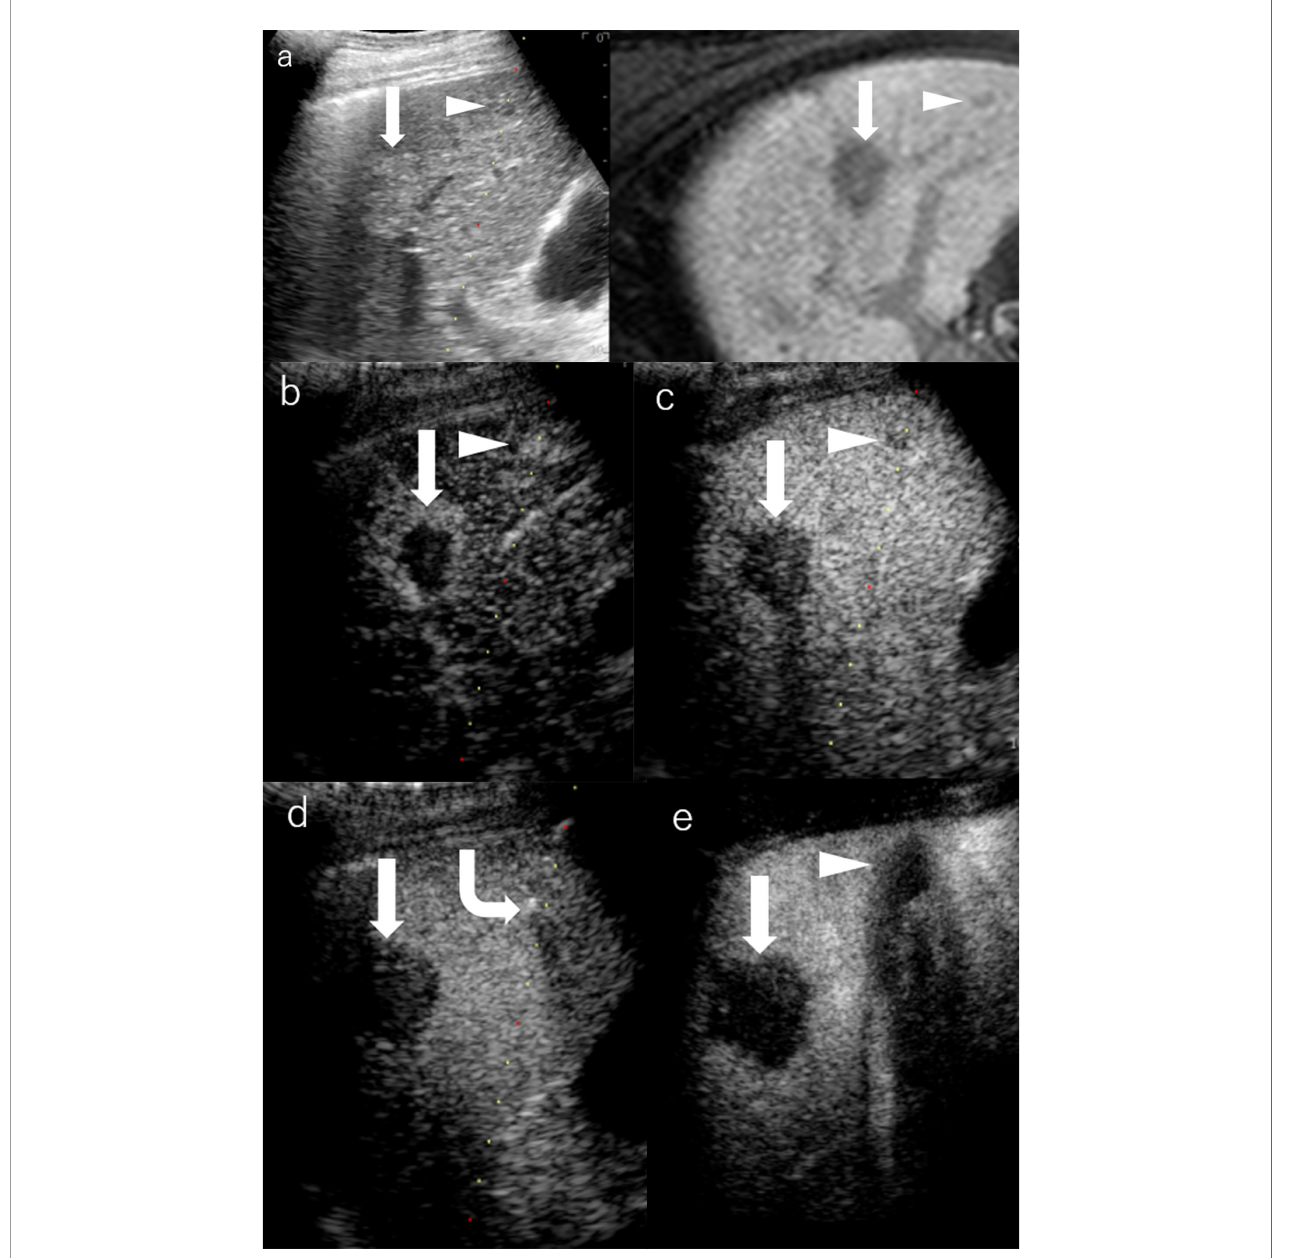
FIGURE 4 | Images of a man in his seventies with a pathological diagnosis of moderately differentiated hepatocellular carcinoma (HCC) and had a history of cirrhosis and HCC. The hepatobiliary phase of EOBMRI (right side), as the reference, was combined with conventional grayscale US (left side), displayed an 8-mm indistinctive hypointense area (the triangular arrow) in segment V on the same screen for the fusion imaging (A) . The extrasmall lesion was hypervascular in the arterial phase of Sonazoid-enhanced ultrasound (US) (B) , while the post-vascular phase indicated it to be a slightly hypoechoic area (C) . Pathway guidance was ready for radiofrequency ablation (RFA) needle manipulation on real-time US (B – D) , along with tracking for the metallic needle tip (the curved arrow) (D) . The contrast- enhanced US (CEUS) evaluated the target ablation area to be non-enhanced after RFA (E) . Arrows indicate the margin of the bigger HCC lesion, which was previously treated by RFA. And Arrowheads indicate the margin of the extrasmall HCC